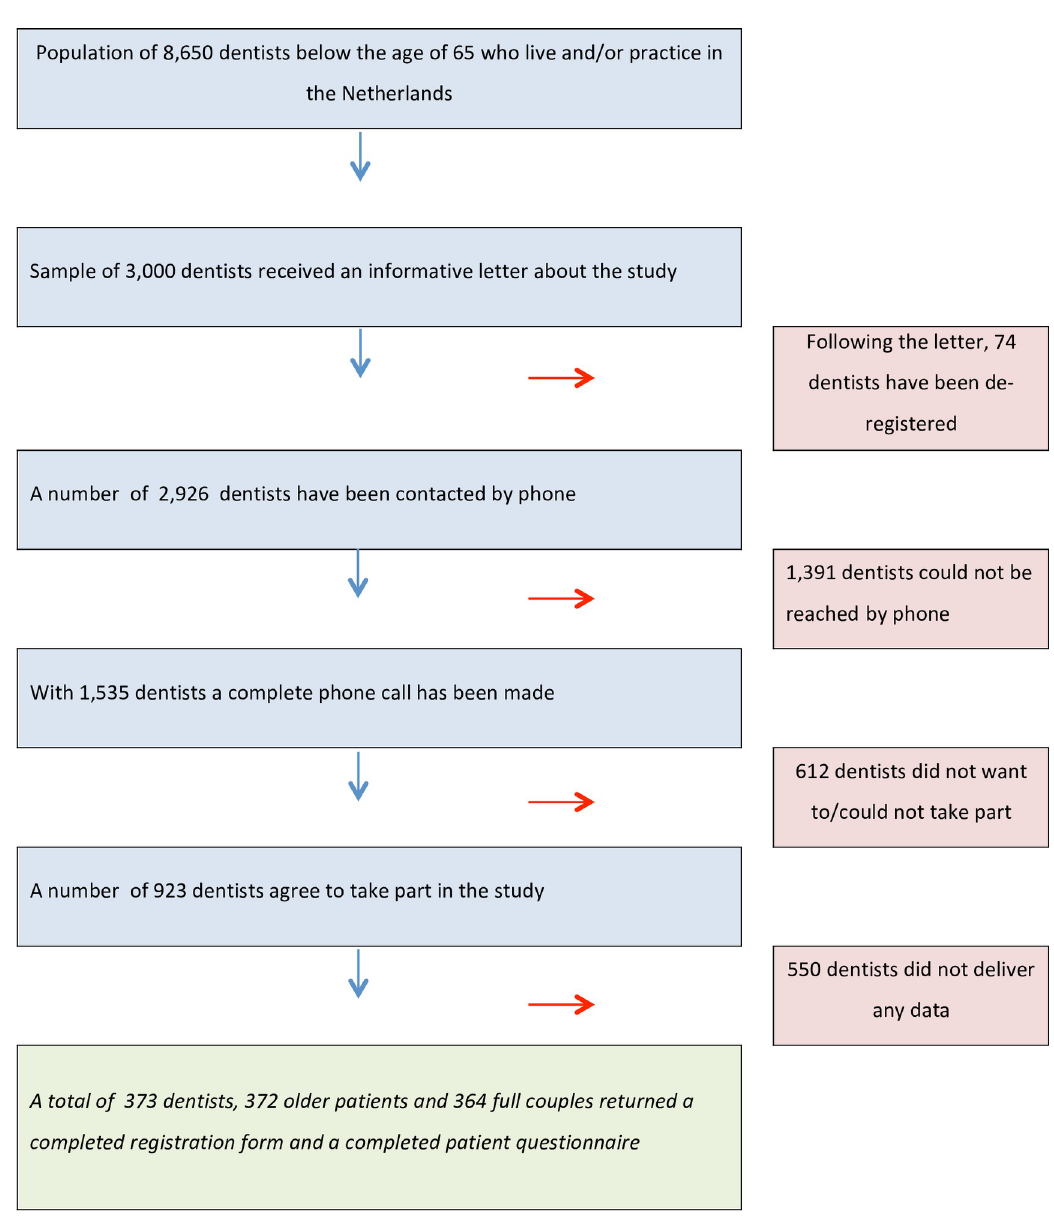
Fig 1. Flowchart of